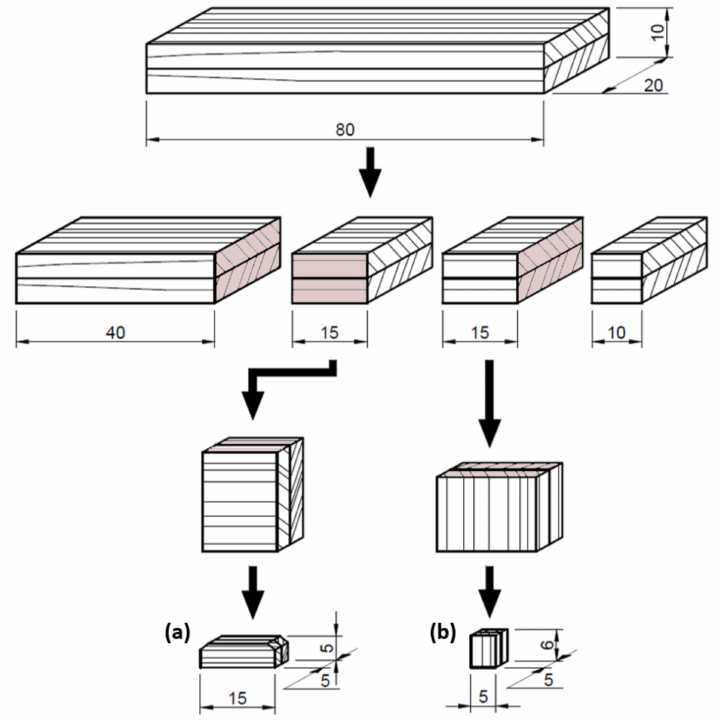
Figure 1. Preparation of the mounting specimens with longitudinal ( a ) and cross-sectional ( b ) cuts of glued joints for SEM analysis.